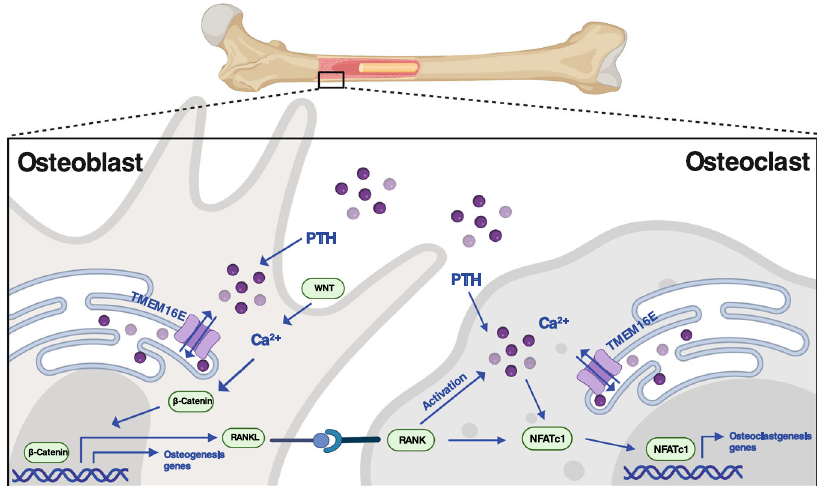
Fig. 7 Schematic diagram of TMEM16E affecting bone metabolism through intracellular Ca 2 + signal transmission. Shown are mechanisms by which TMEM16E in the ER leads to cytosolic Ca 2 + spiking for activation of the WNT/ β -Catenin signaling pathway and RANKL-stimulated NFATc1, thereby triggering Ca 2 + signaling cascades that promote osteoblast and osteoclast differentiation and activation. Created with